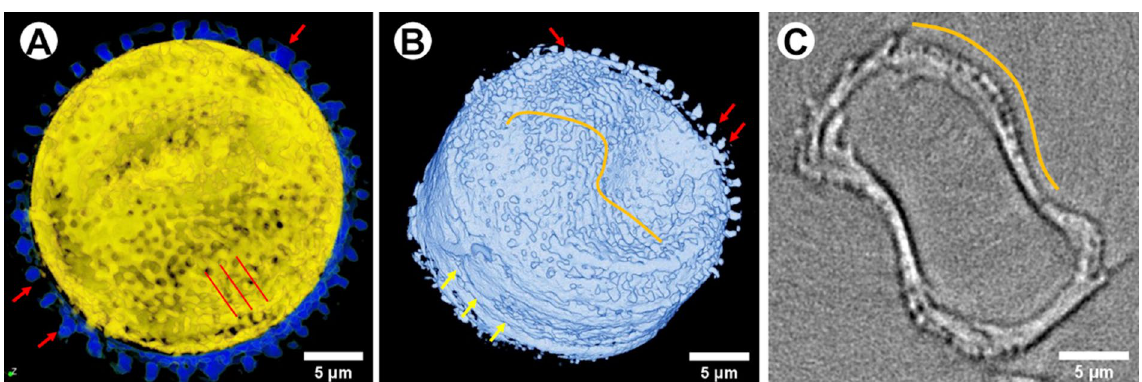
Figure 11. The T. lacustris imaged by nano-XCT. ( A ) Valve surface of T. lacustris , ( B ) the 3D rendering of the of T. lacustris , ( C ) oblique view of the tangentially undulate valve and pores on it. Orange curve line tangentially undulate valve face, red arrows a ring of marginal fultoportulae, red straight lines the coarse and organized striae, yellow arrows the girdle